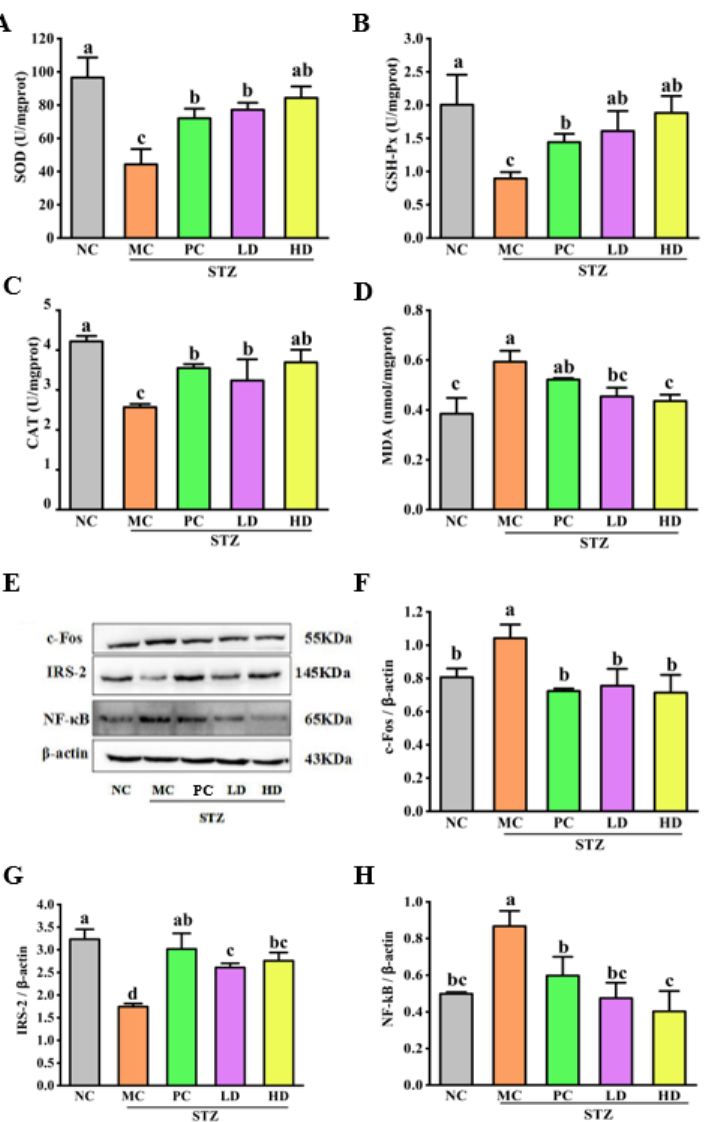
Figure 6. Effect of EPS103 on brain nerve damage in the T2DM mice induced by STZ and HFD. Activities of ( A ) SOD, ( B ) GSH-Px and ( C ) CAT, as well as content of ( D ) MDA in the hippocampus. ( E ) Bands of c-Fos, IRS-2 and NF- κB. Protein expression levels of ( F ) c-Fos, ( G ) IRS-2, and ( H ) NF- κB. β -actin was utilized as loading control. Data are presented as the mean ± SD (n = 3). Different letters indicate statistically significant differences between two groups ( p < 0.05).